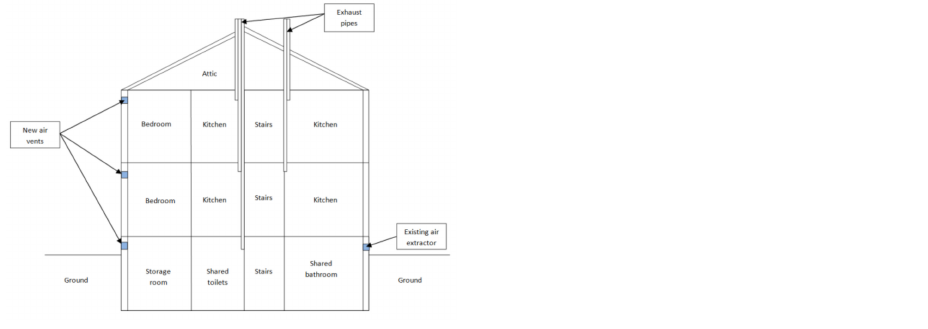
Figure 24. Simplified drawing of the proposed ventilation system for Strandveien 21 (Practical guide by Gendarme,